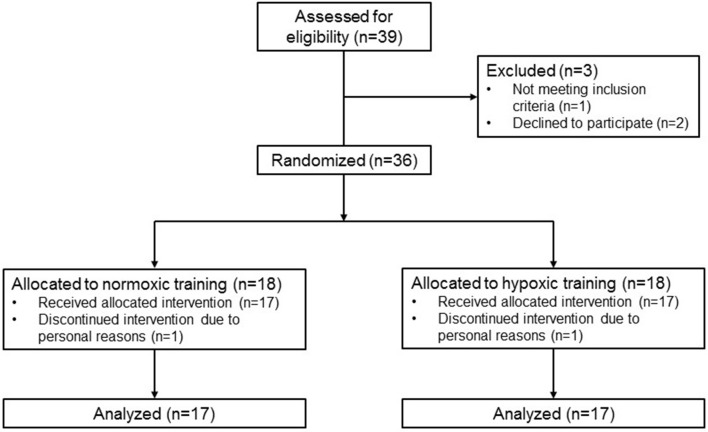
CONSORT 2010 flow diagram.